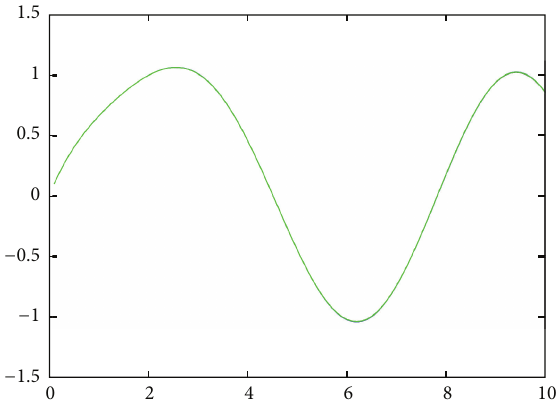
Figure 11: Comparison of real solution (black) and symbolic solutions for 𝑚 = 1000 (dark blue line) and 𝑚 = 10000 (green line).